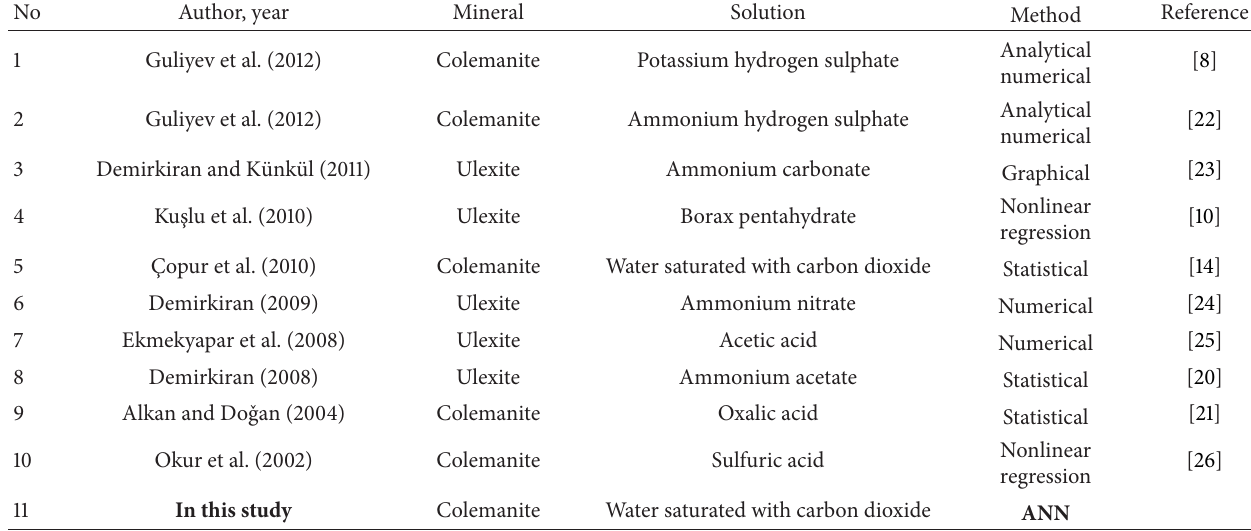
Table 1: Previous studies about dissolution kinetics of boron